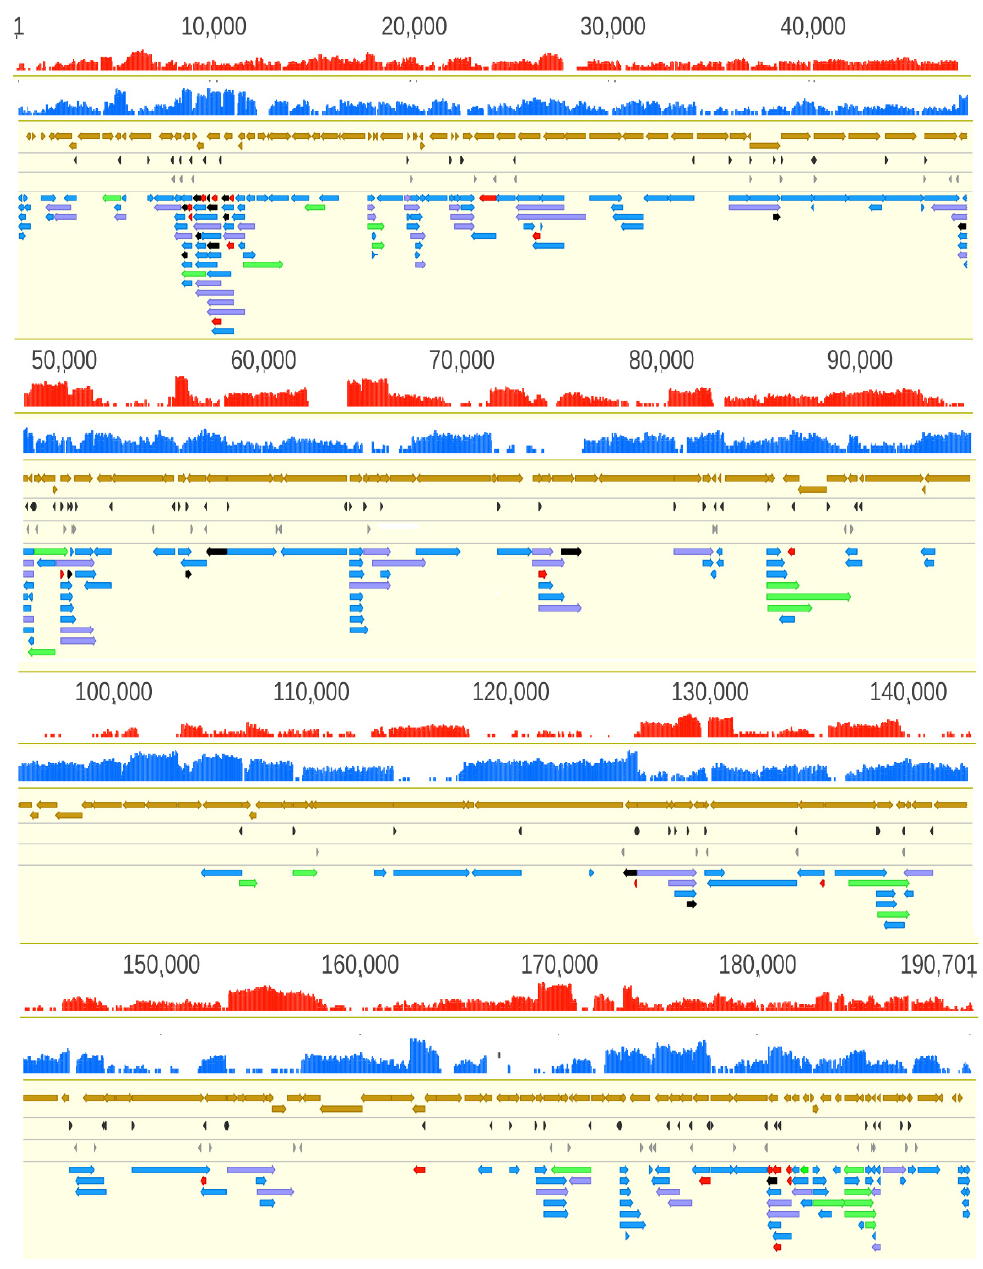
Figure 3. African swine fever virus transcriptome. Panel A illustrates the total transcriptome of ASFV; Panel B. Only those LoRTIA transcripts are depicted of which ratio exceed 2.5% compared to transcripts controlled by the same promoters. The red and the blue histograms represent the coverage of cDNA reads on the two DNA strands. The mRNAs have higher coverage than the antisense RNAs. In principle, asRNAs can be produced from their own promoters, or are the read-through products of convergent genes ( →← ), or are the consequences of transcriptional start sites (TSS) overlaps of divergently oriented gene products ( ←→ ). The proportion of polycistronic transcripts relative to the monocistronic RNAs controlled by the same promoters are shown in Table S7. Color code: light brown arrow-rectangles: coding sequences; dark gray arrow-rectangles: previously annotated TSS; light gray arrow-rectangles: previously annotated TES; black arrow-rectangles: 5 (cid:48) -truncated in-frame ORFs containing transcripts; purple arrow-rectangles: novel polycistronic transcripts; red arrow-rectangles: novel non-coding transcripts; green arrow-rectangles: novel complex